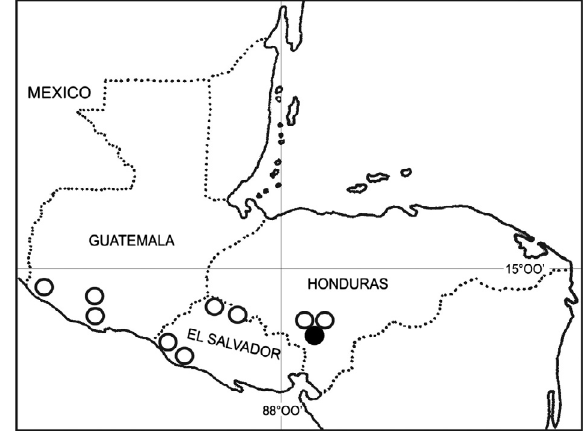
Figure 1. Map of Profundulus spp. collections in Central America (circles). The black circle depicts the single locality in which B. acheilognathi was collected (Nacaome River) within Profundulus portillorum